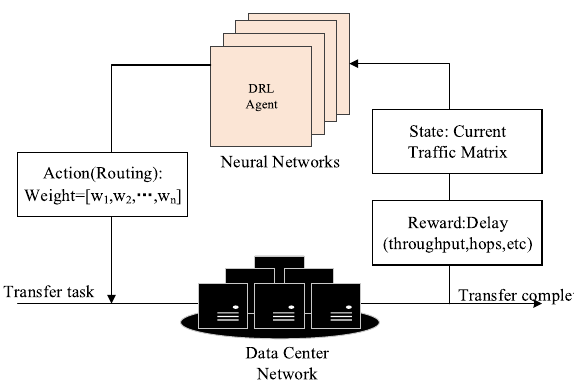
Fig. 2 Reinforcement learning model about